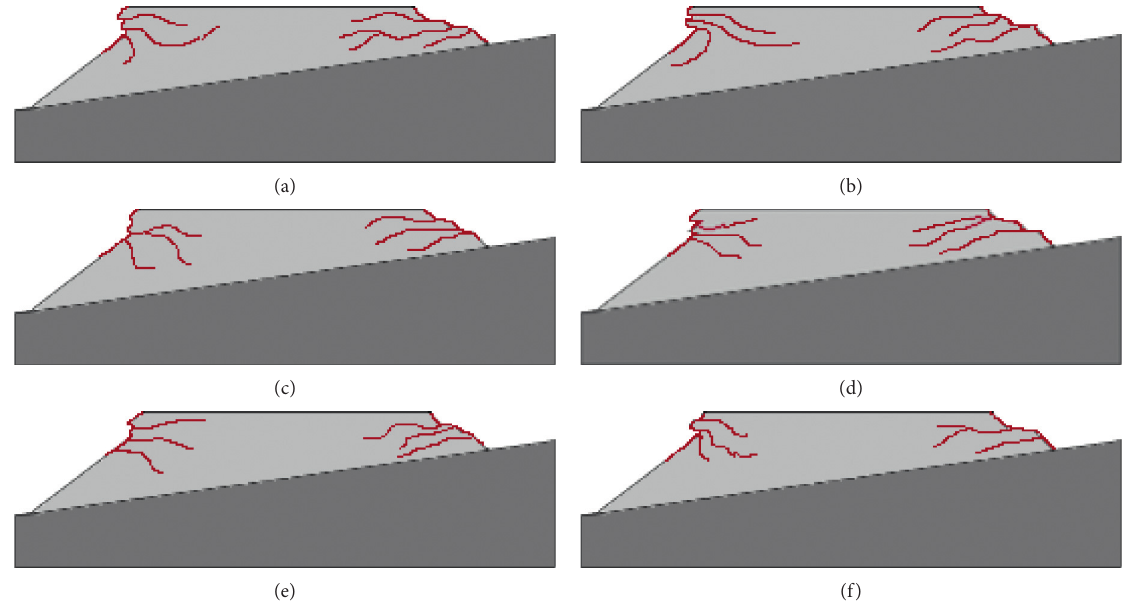
� F � F � 0 and PGA � original value). (a) Seismic damages of 1 2 3